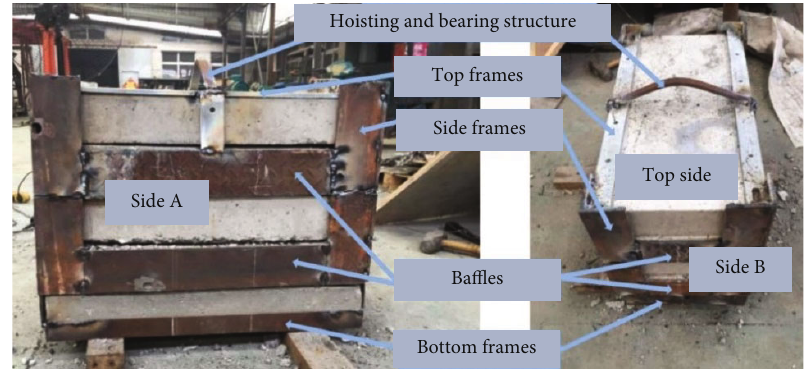
Figure 3: Combined specimens.